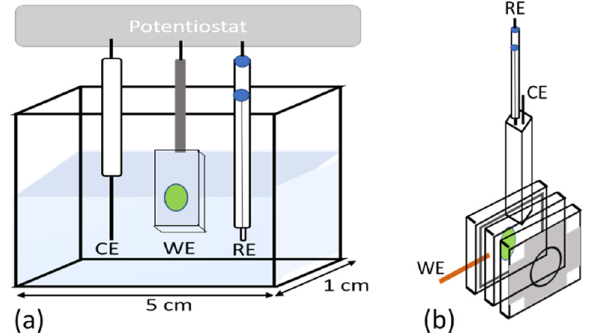
Figure 3. Schemes of the three-electrode photoelectrochemical cells used for: ( a ) photocurrent measurements; ( b ) time-resolved absorption measurements. WE—working electrode, RE—reference electrode, CE—counter electrode.